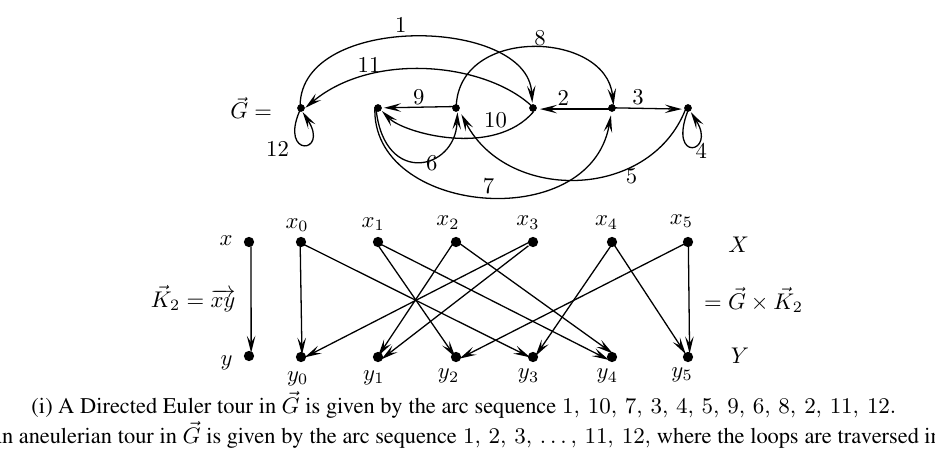
Fig. 3: ~G × ~K 2 , a 2-diregular bieulerian